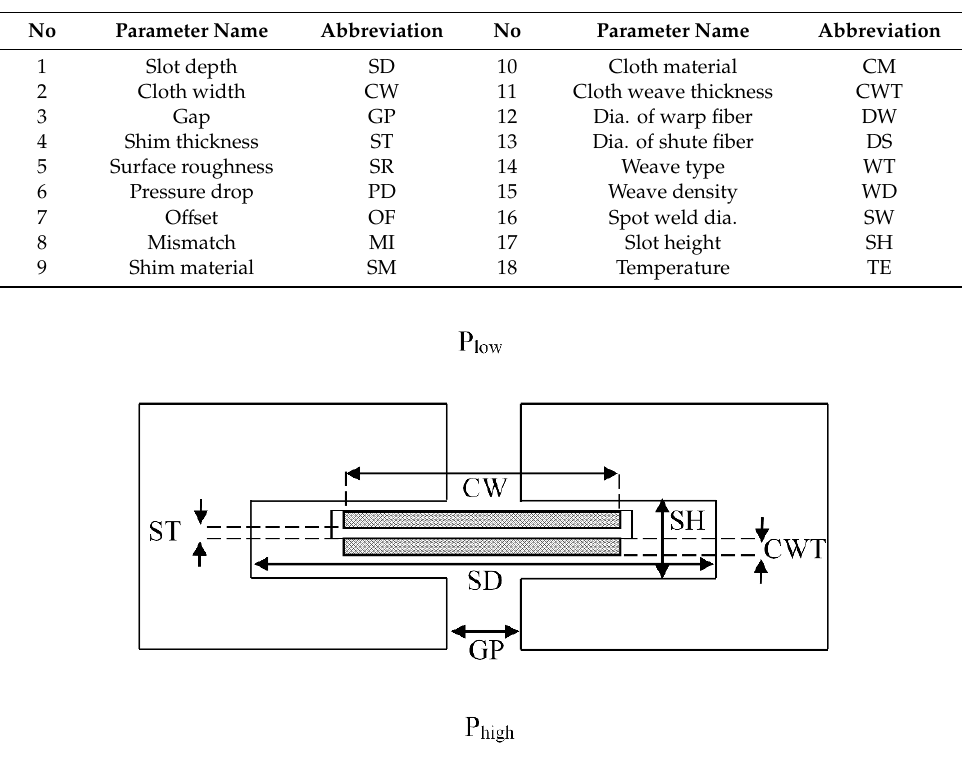
Table 1. Candidate parameters for cloth seal leakage performance study.